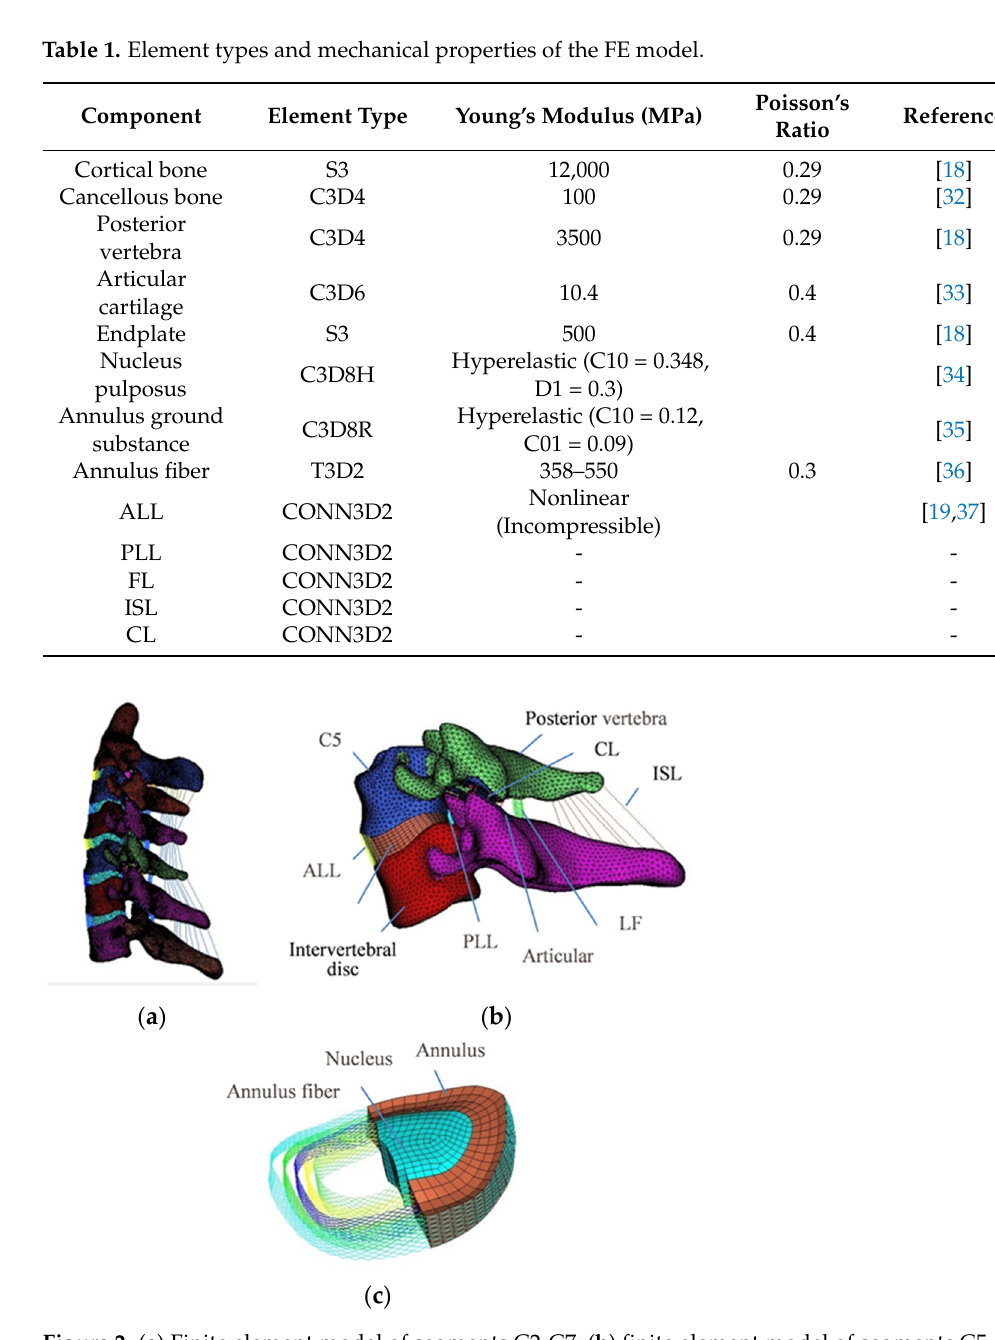
Figure 2. ( a ) Finite element model of segments C2-C7; ( b ) finite element model of segments C5-C6; ( c ) intervertebral disc model. ( c ) intervertebral disc